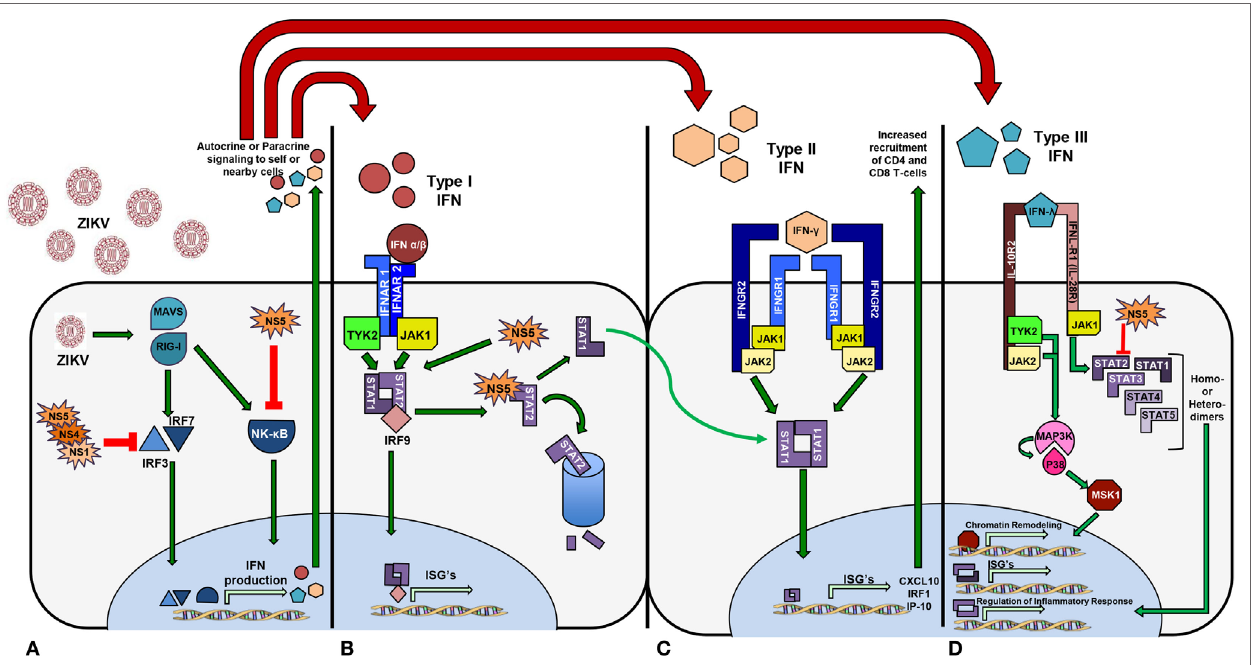
FiGURe 3 | Zika virus activates signaling pathways that promote transcription of interferon (IFN) genes differentially. (A) The NS5 protein from African lineage binds and prevents NF-kB function. Asian lineage non-structural proteins NS5, NS4, and NS1 act to inhibit IRF3 and IRF7 functionality, thus inhibiting IFN production. (B) IFN Type I phosphorylates STAT1 and STAT2 and NS5 targets STAT2 for degradation. (C) Activation of Type II IFN signaling upon receptor binding phosphorylates STAT1 heterodimers and thus increases chemoattractant IFN-stimulated genes. (D) STAT2 is targeted for proteasomal degradation by NS5 resulting in an increased rate of STAT homodimerization and upregulation of anti-inflammatory